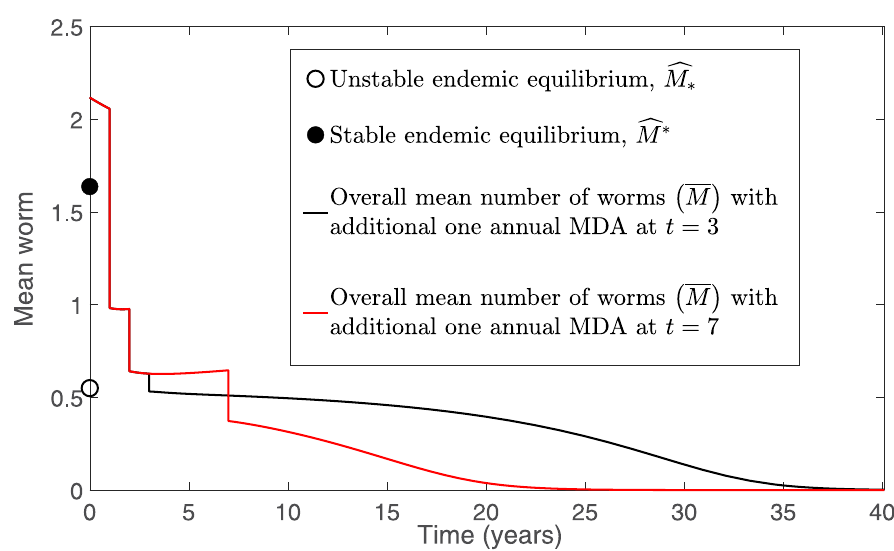
Fig 13. Numerical solutions of model (9) and (10) with an additional round of TUMIKIA community-based annual deworming strategy. Fig 11c: model (3) and (4) forecasts disease eradication if � � 0.73, but model (9) and (10) pre-